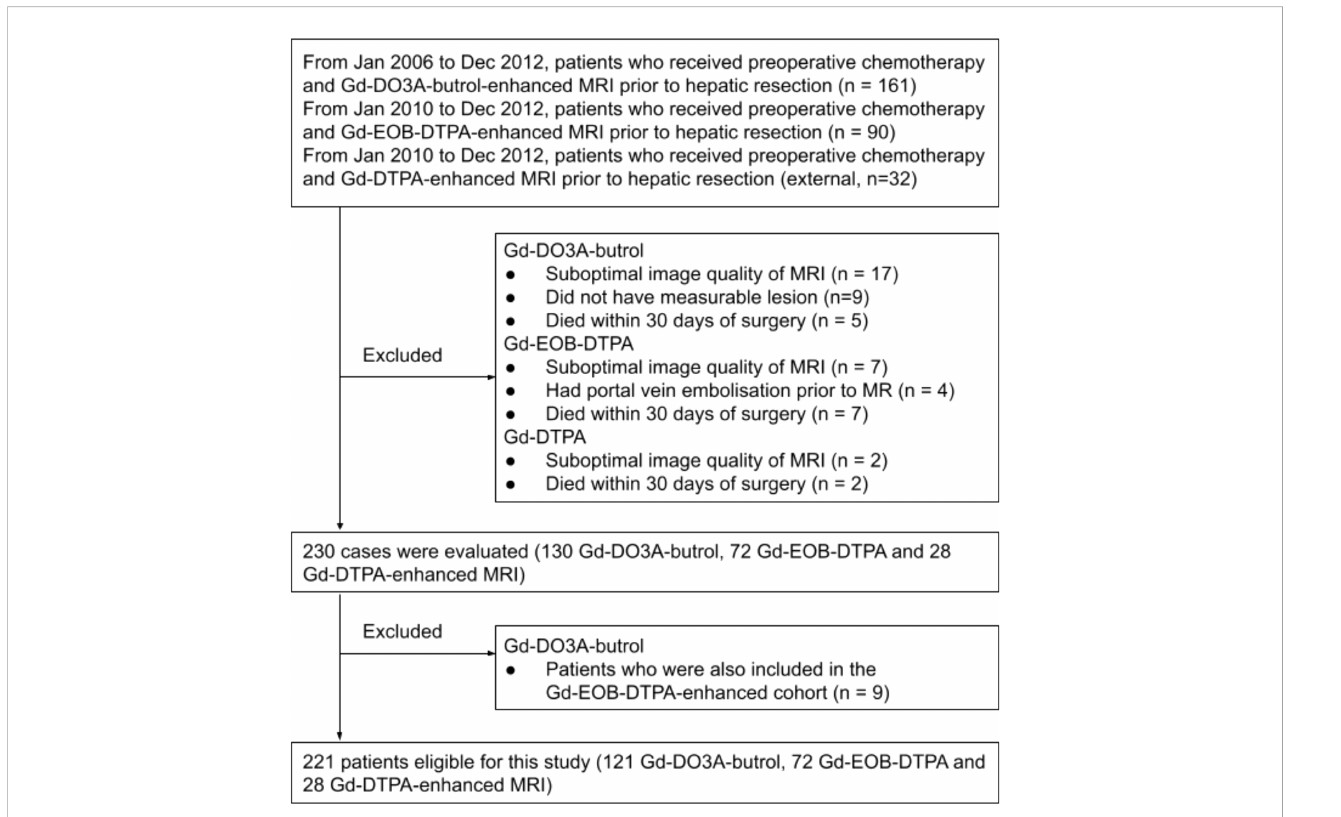
FIGURE 2 Flow chart of the inclusion and exclusion